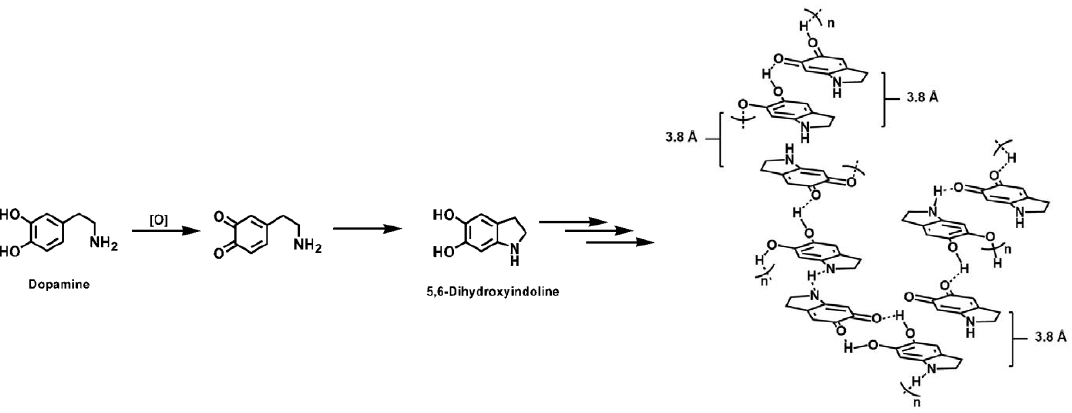
Figure 6. A possible mechanism for the oxidation and polymerization of dopamine to form insoluble aggregates [1,36,37]. Reproduced with permission, ACS Publications, 2012. aggregates [1,36,37]. Reproduced with permission, ACS Publications,